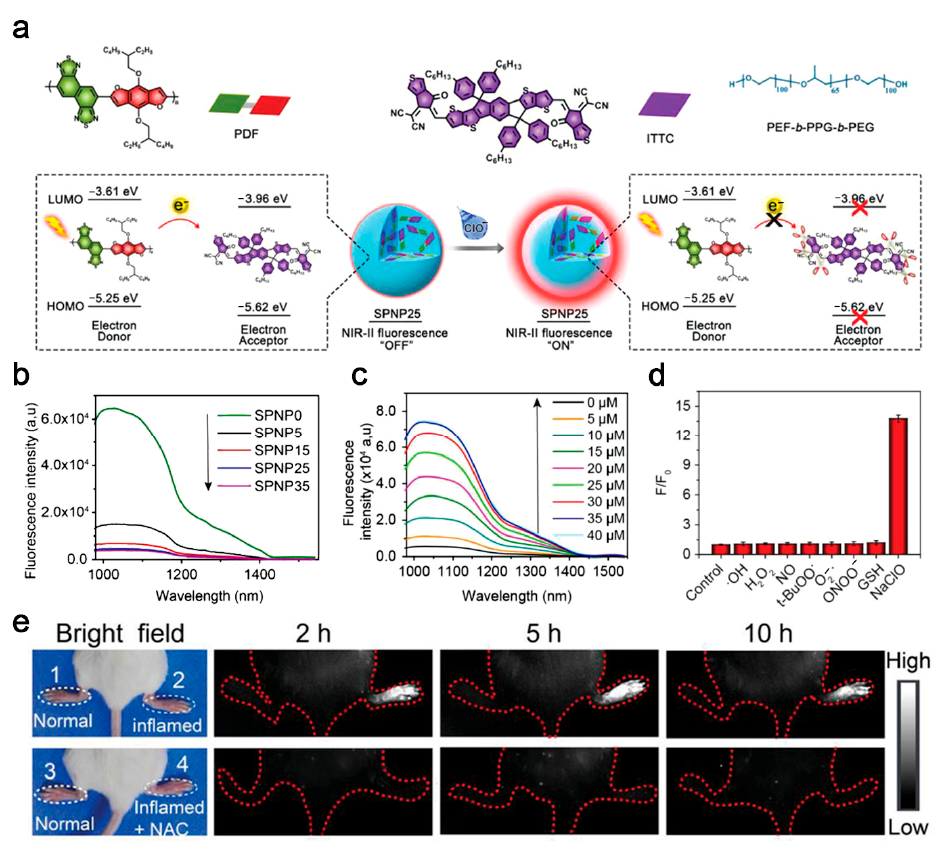
Figure 5. ( a ) Chemical structures of PDF, ITTC, and PEG-b-PPG-b-PEG, and the mechanism of na- noprobe SPNP25 for endogenous ClO − detection. ( b ) Fluorescence intensity of SPNPs doped with different amounts of ITTC. ( c ) Fluorescence spectra of the nanoprobe SPNP25 after reaction with various concentrations of ClO − . ( d ) Fluorescence intensity ratios of nanoprobe SPNP25 toward ClO − (40 µM) and various biochemically related analytes (100 µM). ( e ) Time-dependent fluorescence im- aging in the inflammatory and normal sites of LPS-pretreated and LPS/NAC-treated mice after in- jection of SPNP25. Reproduced with permission [95]. Copyright 2019, WILEY-VCH. 3.4. RNS RNS are highly reactive biological oxidation species containing nitrogen, mainly in- cluding nitric oxide (NO), peroxynitrite (ONOO − ), and S-nitrosothiols (RSNO) [21,96]. In common with ROS, RNS play an important role in oxidation processes under physiologi- cal conditions which are related to oxidative stress, brain diseases, cancer, and inflamma- tion [97–99]. In fact, ONOO − is not only related to the nitration of proteins in immune cells in tumors, affecting the immunosuppression of tumors, but is also related to the occur- rence and development of brain injury [100,101]. Traumatic brain injury (TBI) is highly likely to cause disability and death in humans unless it can be easily diagnosed at an early stage [102]. Currently, clinical diagnosis of TBI is mainly achieved using magnetic resonance imaging (MRI) and computed tomogra- phy (CT), but these are difficult to use for real-time early diagnosis of TBI. As reported, ONOO − is a biomarker of early TBI which is accompanied by the occurrence and devel- opment of TBI [103,104]. Therefore, the occurrence of early TBI can be diagnosed by mon- itoring the biomarker ONOO − . In 2020, Li et al. reported an activated NIR-II fluorescent probe (V&A@Ag 2 S) composed of a targeting group (VCAM1 binding peptide), an A1094 chromophore NIR absorber, and Ag 2 S QD (Figure 6a) [105]. Specifically, there is a large overlap between the NIR-II fluorescence emission spectrum of Ag 2 S QD and the absorp-